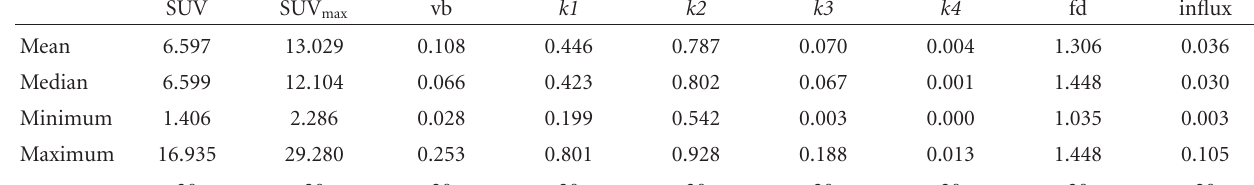
Table 1: Statistical data for the PET parameters.